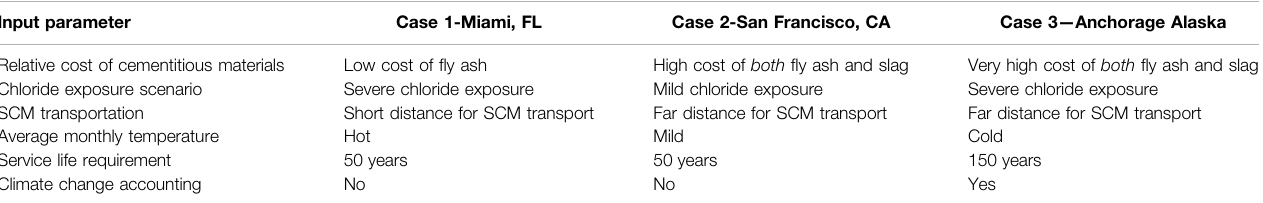
TABLE 6 | Qualitative summary of input parameters speci fi c to each case